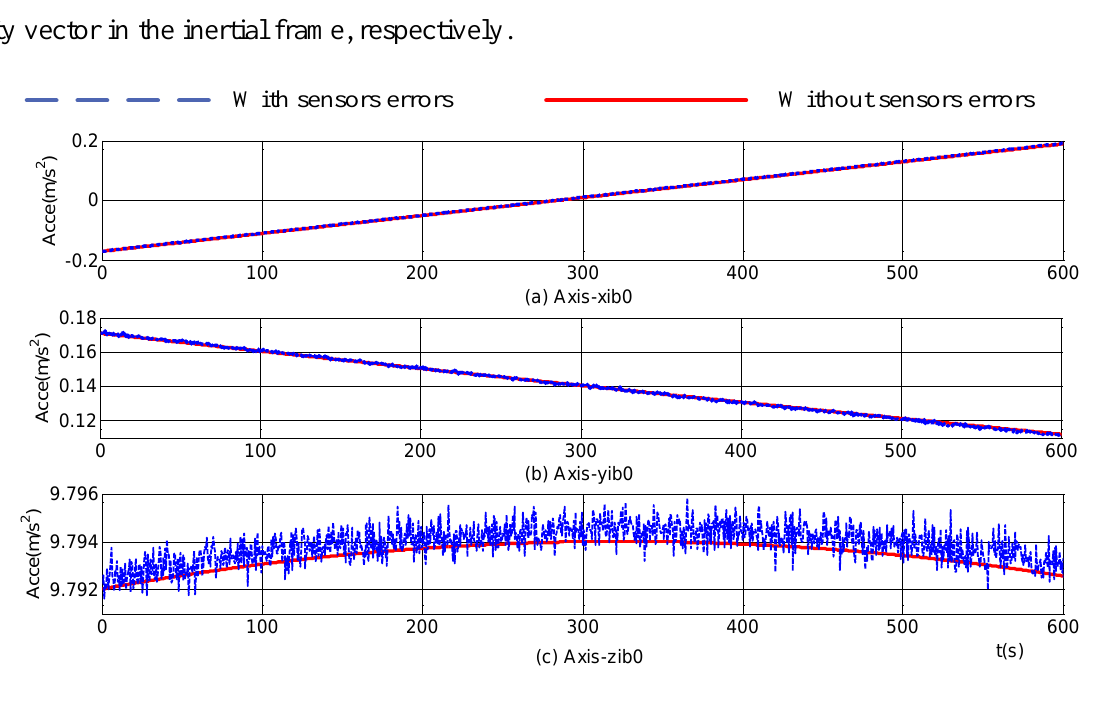
Figure 6. Projections of gravitational apparent motion in inertial